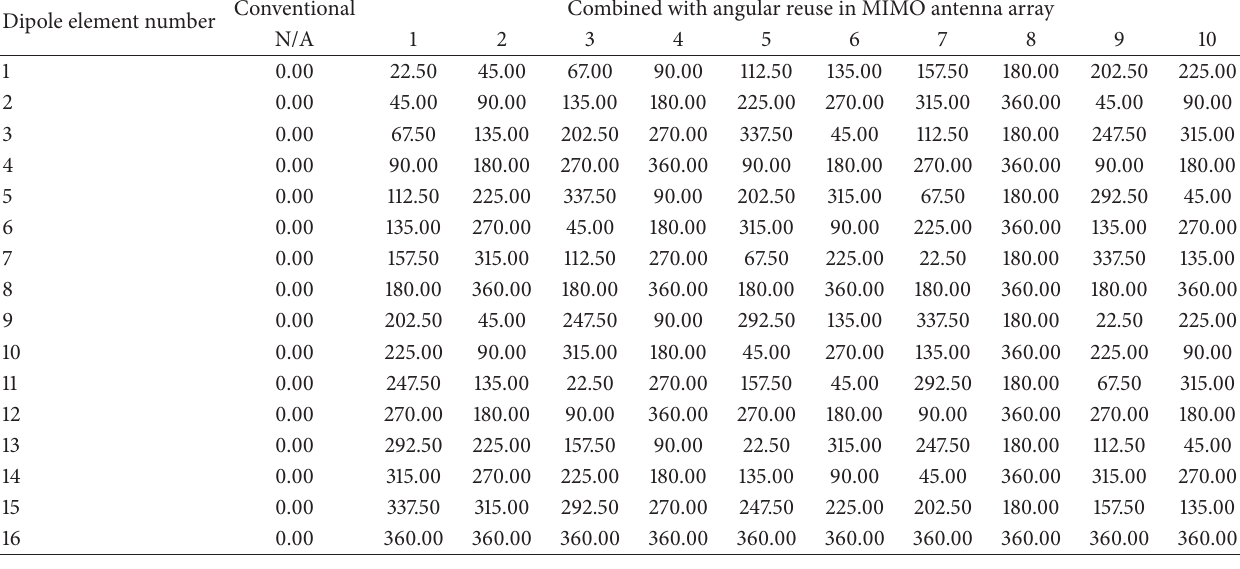
Table 1: Angular orientations of MIMO antenna array design variations ( ∘ ).